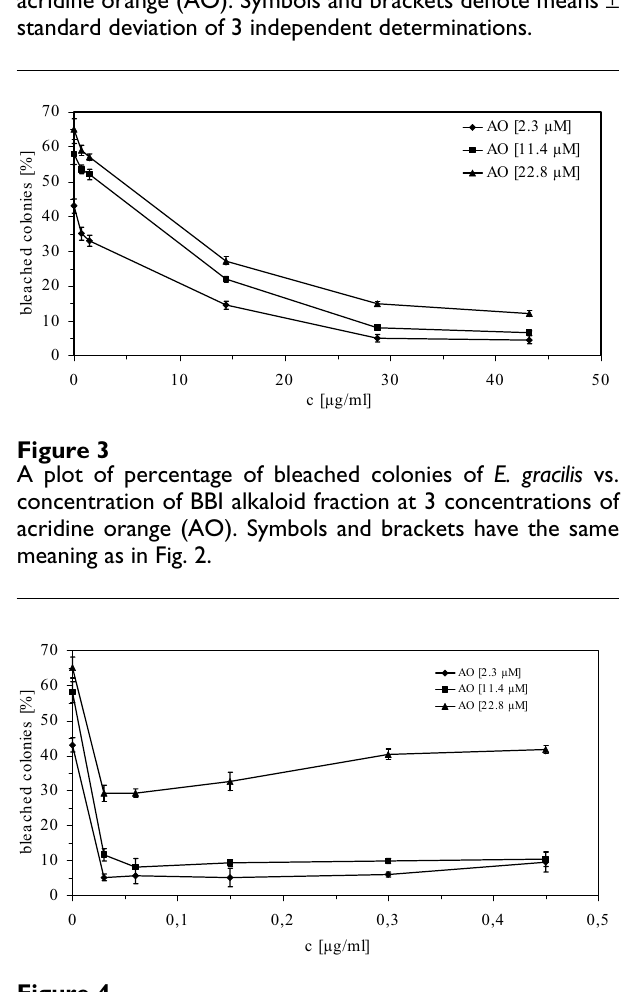
Figure 4 A plot of percentage of bleached colonies of E. gracilis vs. concentration of berberine at 3 concentrations of acridine orange (AO). Symbols and brackets have the same meaning as in Fig.